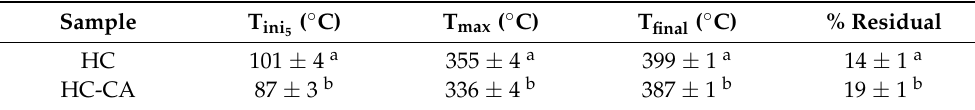
Figure 7. ( A ) Primary and derivative representative thermograms and ( B ) DSC curves of HC-CA and HC samples. Data were processed using OriginPro 2015 software. Table 2. Thermal behavior of HC-CA and non-functionalized hemp cellulose (HC) samples (values are expressed as mean ± SD, n = 3).